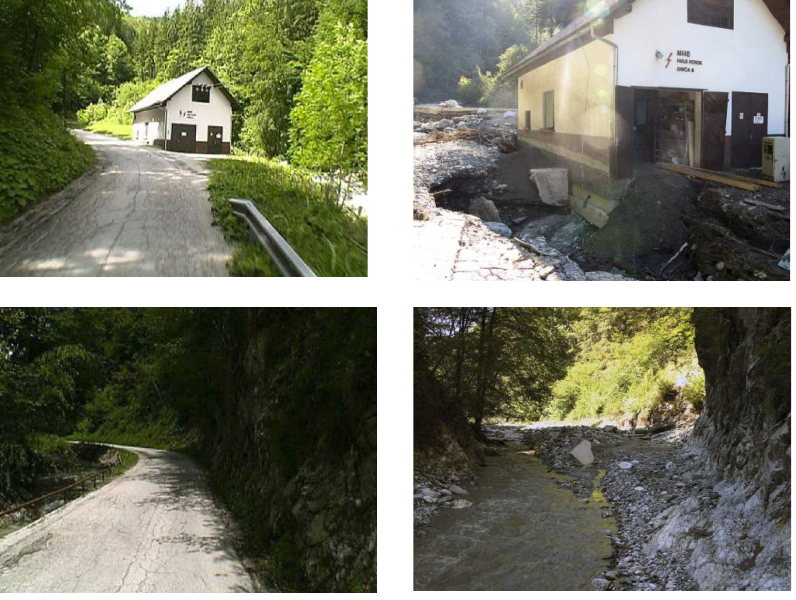
Fig. 3. Images presenting the impact of the 2007 flash flood at two locations of Zali Log – Dav`ea area (source: Environmental Agency of the Republic of Slovenia).